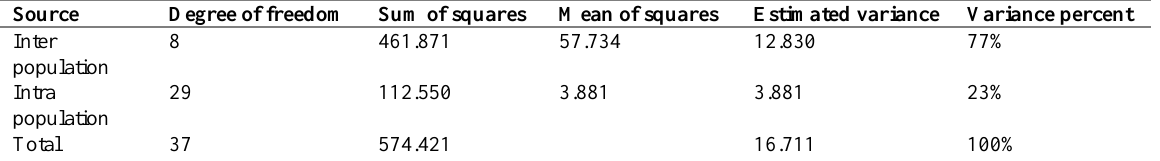
Table 10. The results of molecular data analysis of variance (AMOVA) of studied violet populations. Source Degree of freedom Sum of squares Mean of squares Estimated variance Variance